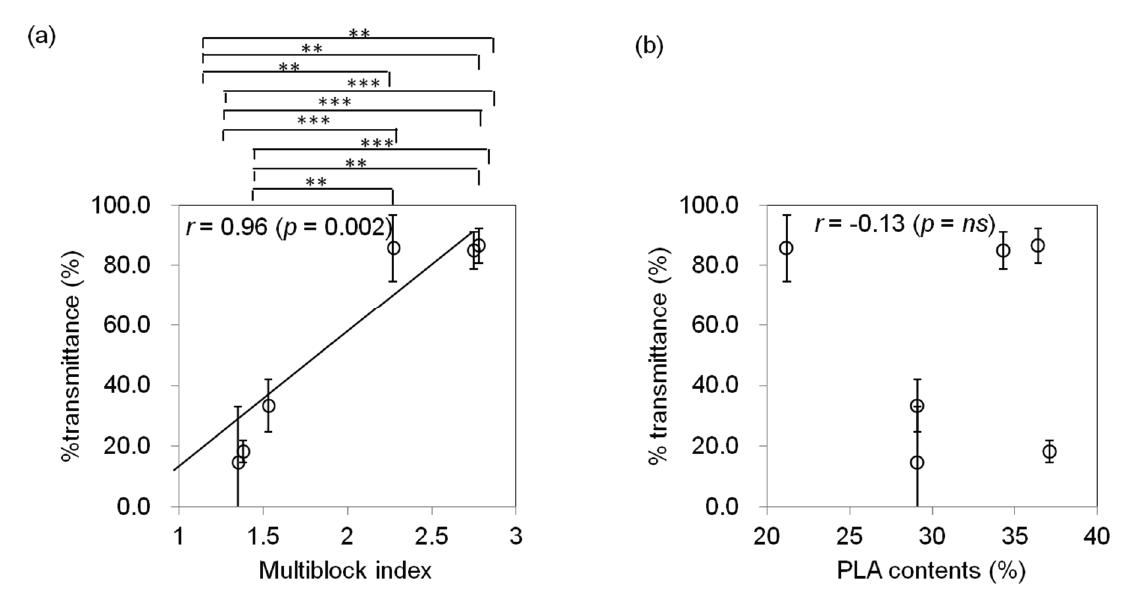
Figure 5. Light transmittance change of the PLA–PEG copolymers suspension (1 wt%) ( a ) multiblock indexes and ( b ) PLA content at room temperature (** p < 0.005, *** p <